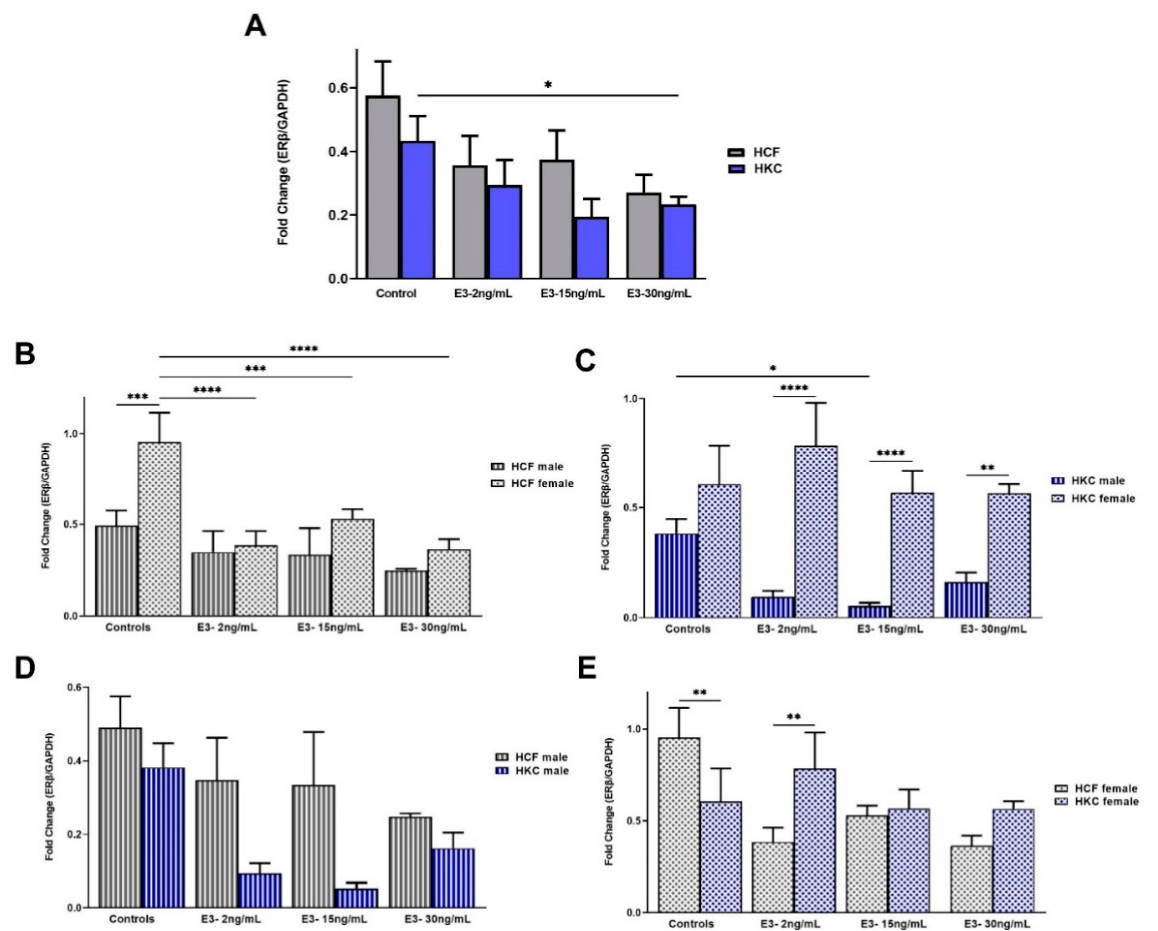
Figure 8. Expression of ER β in 3D HCFs and HKCs in response to 2, 15, 30 ng/mL E3 stimulation for four weeks. ( A ) Overall ER β expression in HCFs and HKCs ( n = 6). ( B ) Sex-specific expression of ER β in HCFs ( n = 3). ( C ) Sex-specific ER β expression in HKCs ( n = 3). ( D ) Male-specific ER β expression in HCFs vs. HKCs ( n = 3). ( E ) Female-specific expression of ER β in HCFs vs. HKCs ( n = 3). * p < 0.05, ** p < 0.01, *** p < 0.001, and **** p < 0.0001.